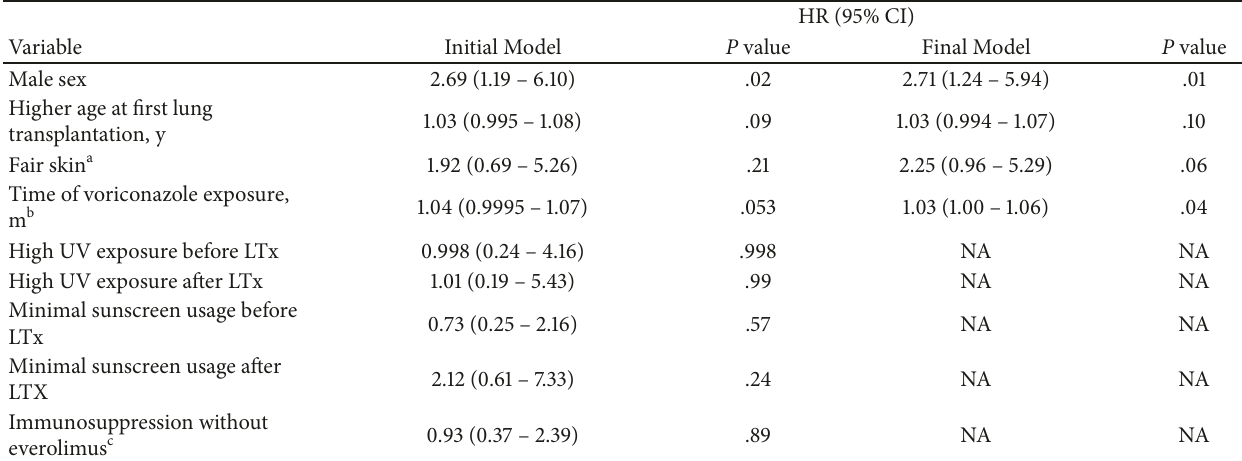
Table 5: Cox regression of risk factors for NMSC or precancerous lesions after lung transplantation.